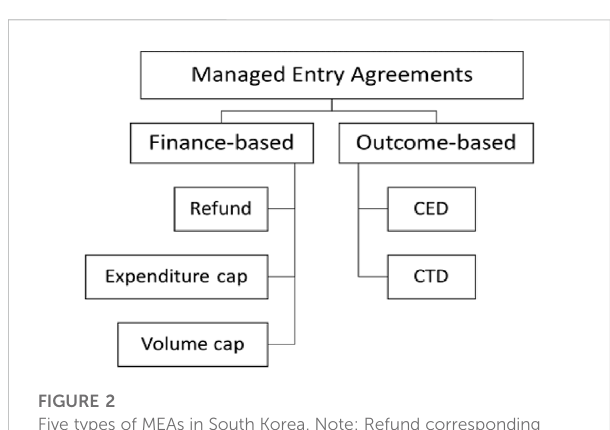
FIGURE 2 Five types of MEAs in South Korea. Note: Refund corresponding to the con fi dential discount. CED, Coverage with Evidence Development; CTD, Conditional treatment